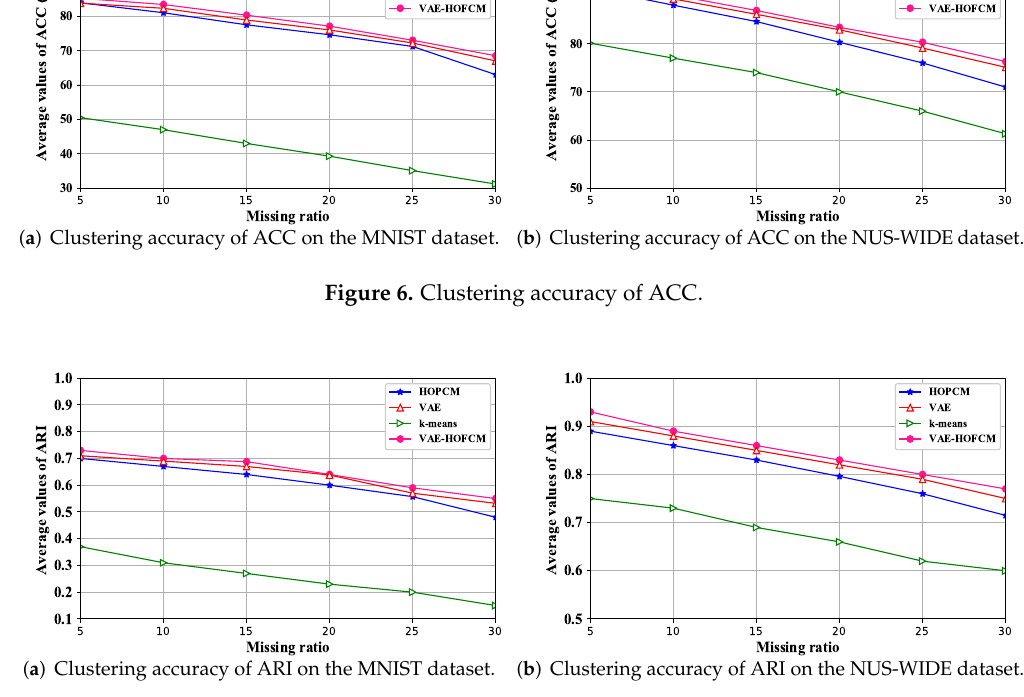
Figure 7. Clustering accuracy of